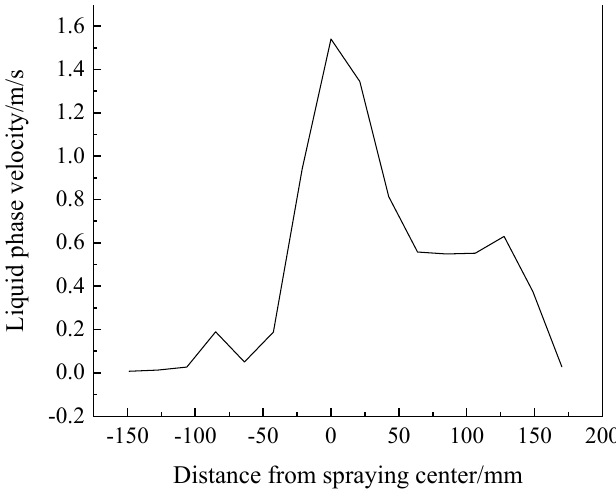
Figure 5. Velocity curve of the fog field at 20 mm from the workpiece.